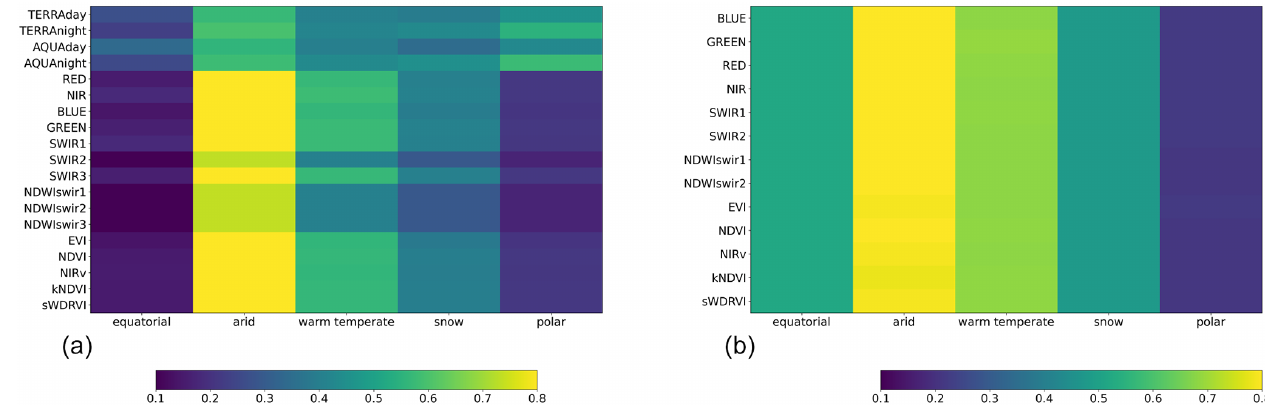
Figure 1. Fraction of good-quality data in the MODIS (a) and Landsat (b) time series. Colours represent the median data availability in tower pixels across sites grouped by Köppen climate classification. Data refer to the period 2003–2020 for MODIS (the time period when both Terra and Aqua satellites are in space) and 1990–2017 for